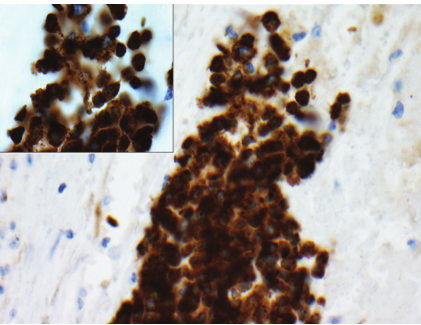
Figure 3: Immunohistochemical stain CD71 shows erythroid pre- cursors, magnification 400x (insert